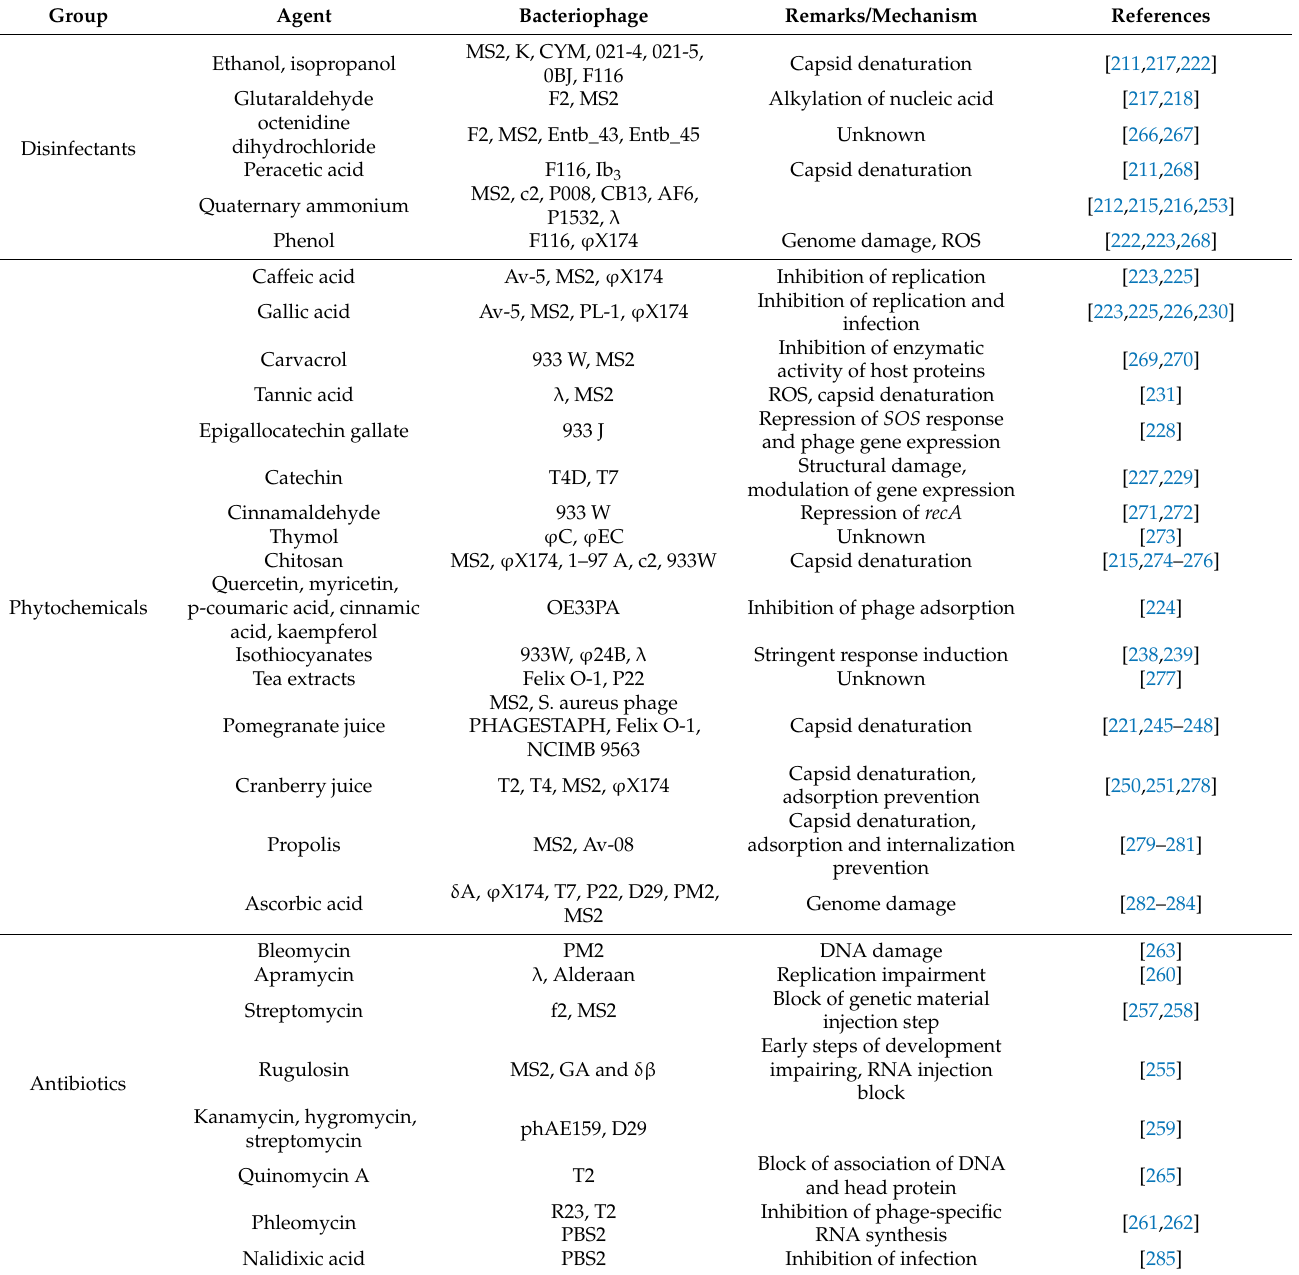
Table 4. The organic agents used for phage